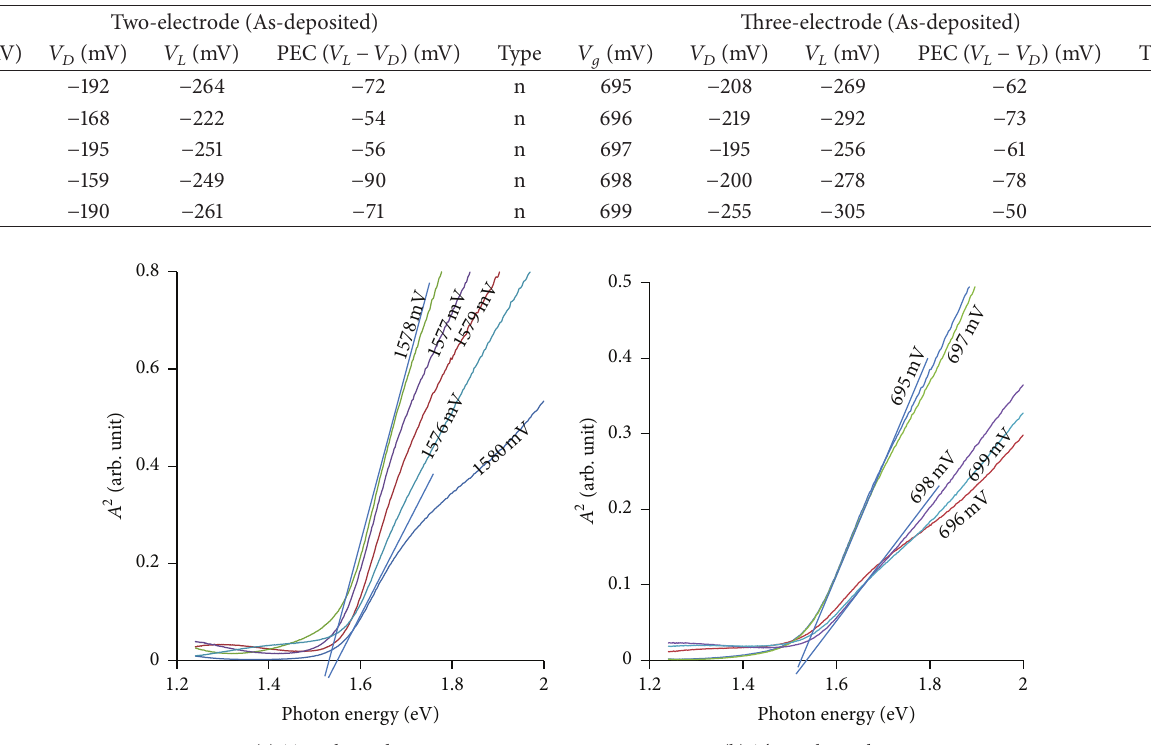
Table 1: PEC signal results of as-deposited CdTe layers grown using the two-electrode system and three-electrode system. Two-electrode (As-deposited) Three-electrode (As-deposited)